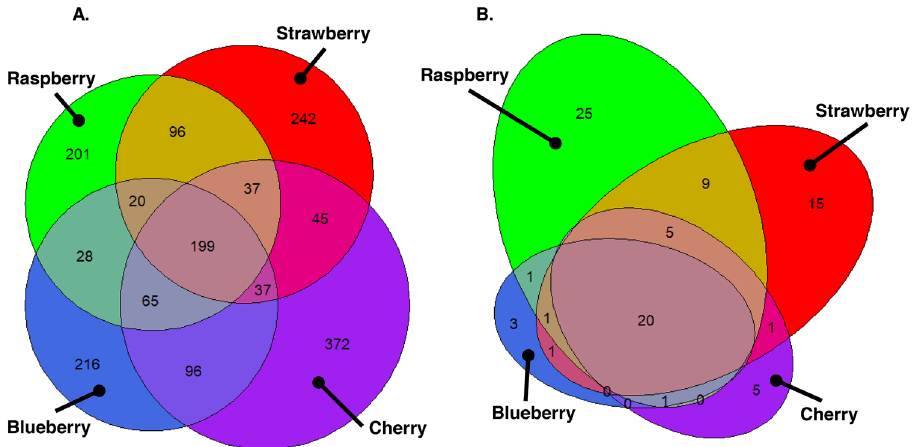
Figure 5. Comparison of shared and discrete numbers of fungal and Saccharomycetales phylotypes between fruits. Venn diagrams of phylotype counts across fruit types for ( A ) all fungal phylotypes, and ( B ) Saccharomycetales phylotypes; overlapping segments are approximately proportional to